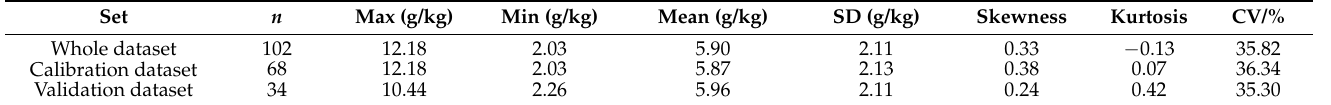
Table 4. Statistical descriptions of the soil organic carbon (SOC) in the whole, calibration and validation datasets.